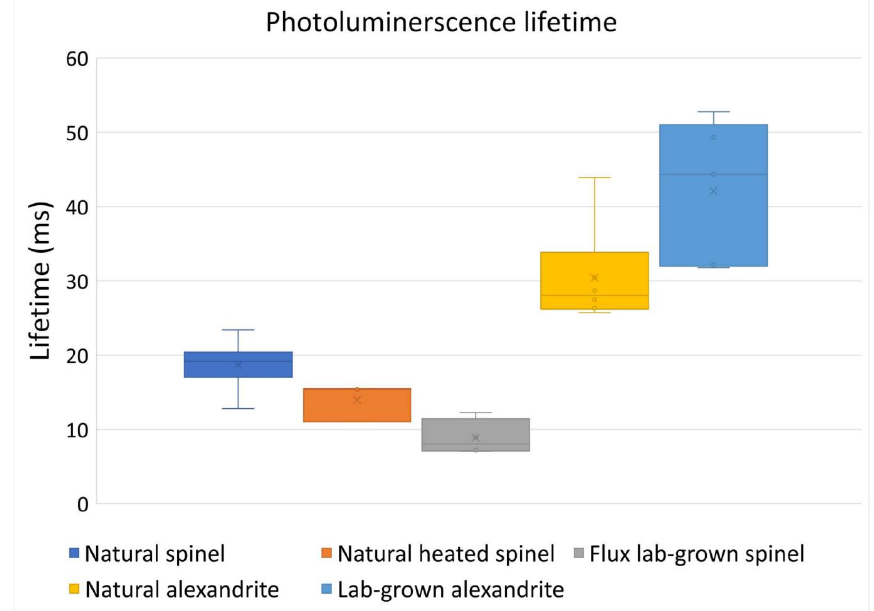
Figure 6. PL lifetime of the analyzed spinel and alexandrite samples.